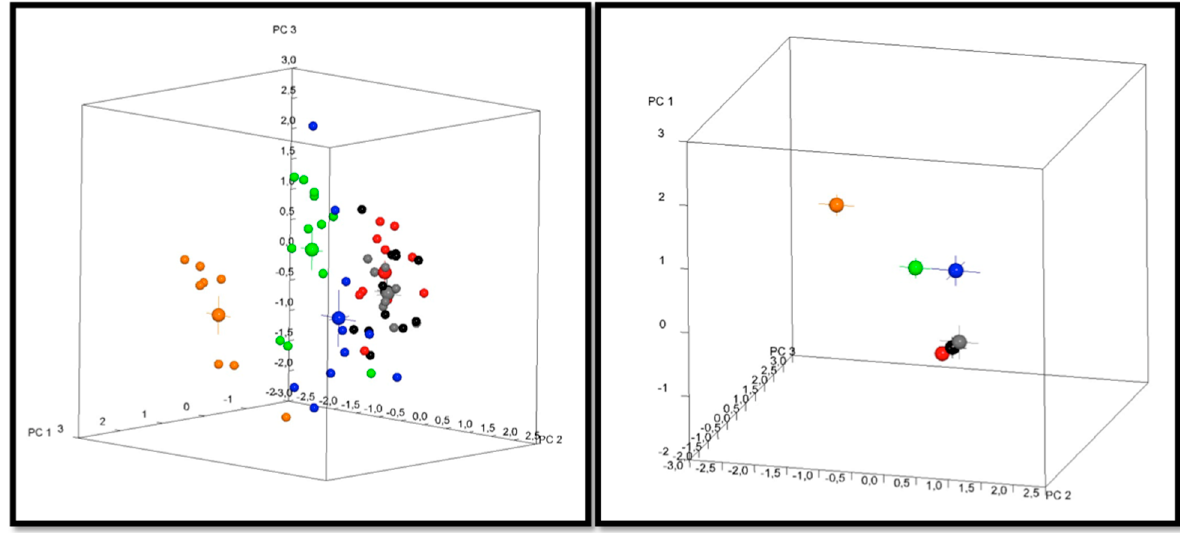
Figure 3. Plot sample for the morphometric analysis. S1 (blue), H1 (red), S2 (green), H2 (grey), S3 (orange), H3 (black). On the left box, all the measurements and their means are displayed. On the right box, the means of the measurements are displayed.